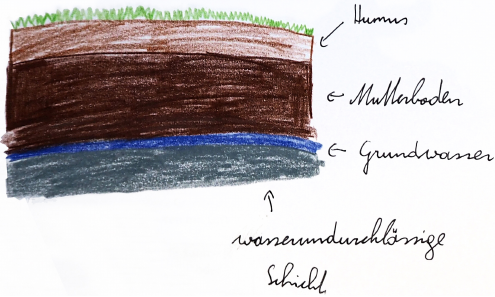
Figure 4. Examples for the categories of analysis. Groundwater as a subterranean river. Mutterboden (soil); see caption of Fig. 2 for further translations.